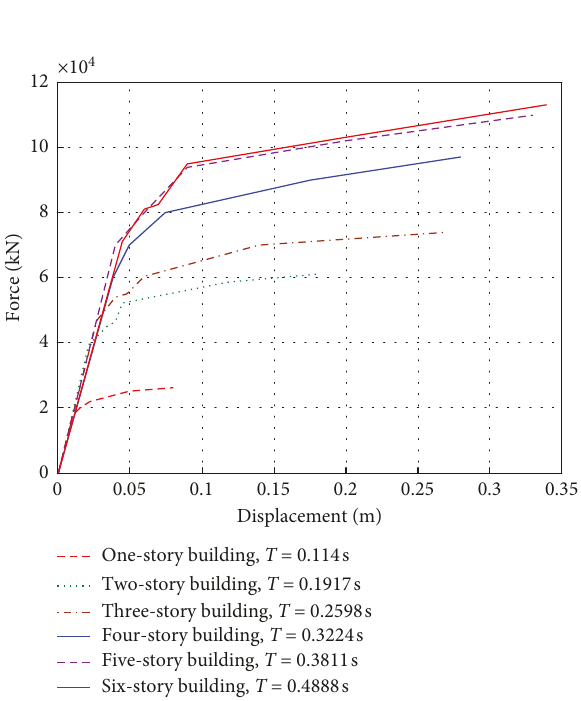
Figure 1: Force-displacement curves of the six inelastic buildings.